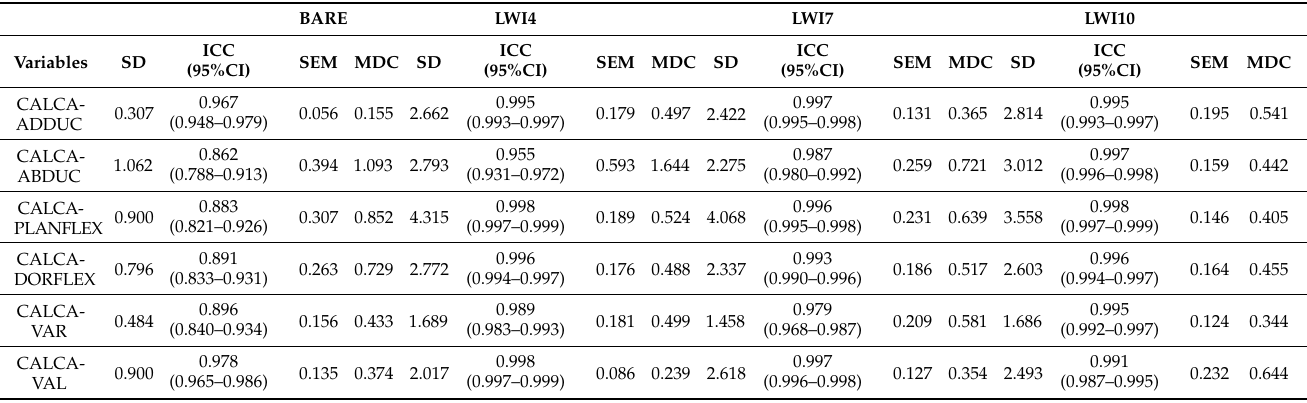
Table 4. The reliability of data for ICC, SEM, and MDC of the calcaneus bone in barefoot condition and wearing lateral wedge